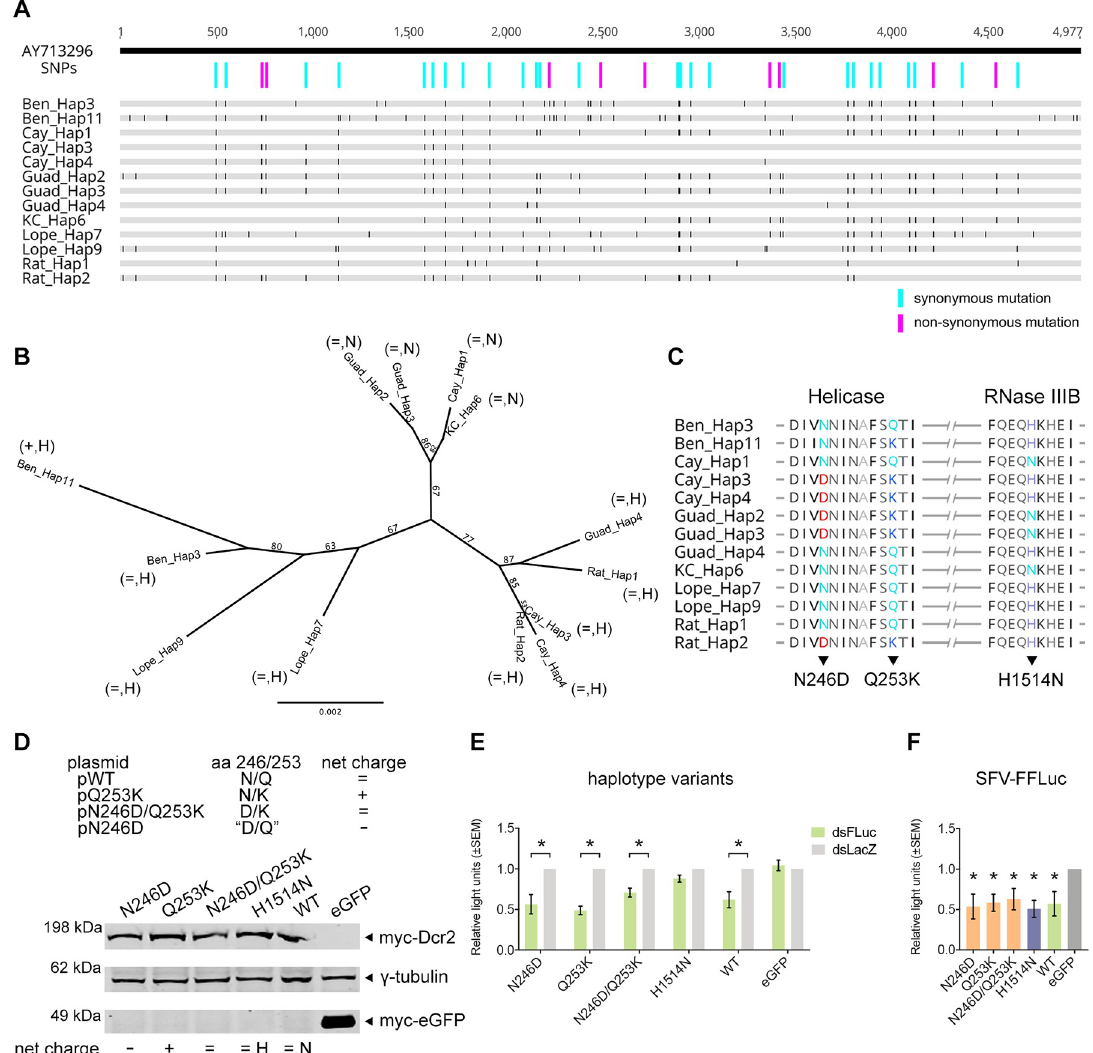
Fig 2. Naturally occurring Dcr2 variants among field-derived mosquito populations. (A) Dcr2 haplotypes (in grey) were identified from early generation colonies of Ae . aegypti initially collected from Cameroon (Ben), French Guiana (Cay), Guadeloupe (Guad), Cambodia (KC and Rat), and Gabon (Lope) and aligned to a reference WT Dcr2 sequence (GenBank ID: AY713296; thick black line) to determine SNPs. Black bars show disagreements to WT Dcr2 with silent and non-synonymous SNPs highlighted by cyan and magenta bars, respectively. (B) Phylogenetic tree of putative amino acid sequences of haplotypes highlighting the amino acid net charge at positions 246/253 (+: positive, -: negative, =: neutral) and an H or N at position 1514. Numbers on branches indicate % consensus support with the substitution rate measured by the scale bar. (C) Alignment of haplotypes highlighting amino acid variants N246D and Q253K in the helicase, and H1514N in the RNase IIIB domain. (D) Mutagenesis of WT Dcr2 to generate amino acid mutations at position 246/253 (aa 246/253) and a theoretical "D/Q" variant (N246D; negative charge) not observed among the surveyed mosquito populations. To check for Dcr2 expression, AF319 cells transfected with variant or WT Dcr2 (peGFP as control) were lysed and probed for myc-Dcr2 by immunoblot using anti-myc tag and γ -tubulin (loading control) antibodies. Representative blot of n = 2 independent repeats is shown. (E) RNAi reporter assay was performed to determine the effect of the variants on silencing activity. AF319 cells co- transfected with WT or variant Dcr2 plasmids (peGFP as control) and FFLuc and RLuc reporter plasmids with dsRNA targeting FFLuc (dsFLuc) or dsLacZ (non-targeting control). At 24 hpt, luciferase levels were measured and shown as mean ± SEM relative light units (FFLuc/RLuc) versus dsLacZ set to 1 compared to eGFP control from n = 3 independent repeats with � = p < 0.05 according to two-way ANOVA. (F) Antiviral activity of Dcr2 variants against SFV-FFLuc (MOI = 0.1) was determined in AF319 cells transiently expressing variant or WT Dcr2 (peGFP as control). Cells were infected 24 hpt. At 48 hpi, FFLuc readings were measured and presented as mean ± SEM relative light units compared to eGFP control set to 1 from n = 3 independent repeats with � = p < 0.05 versus control according to two-way Student’s t-test.